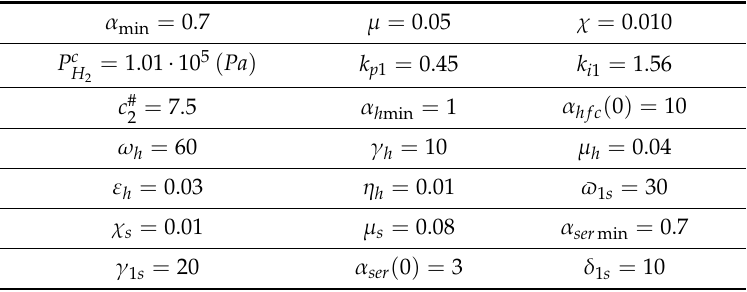
Table 2. The parameters of the controllers v 1 , v 2 , v 3 , v 4 , and v 5